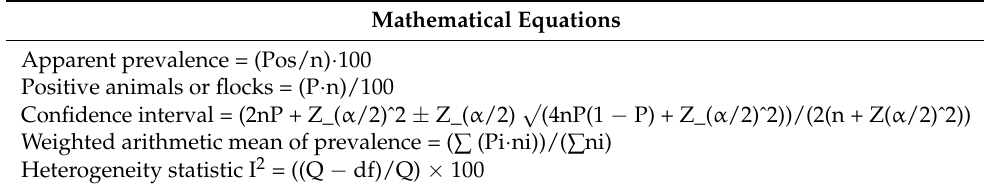
Table 1. Definition of the parameters used in the epidemiological